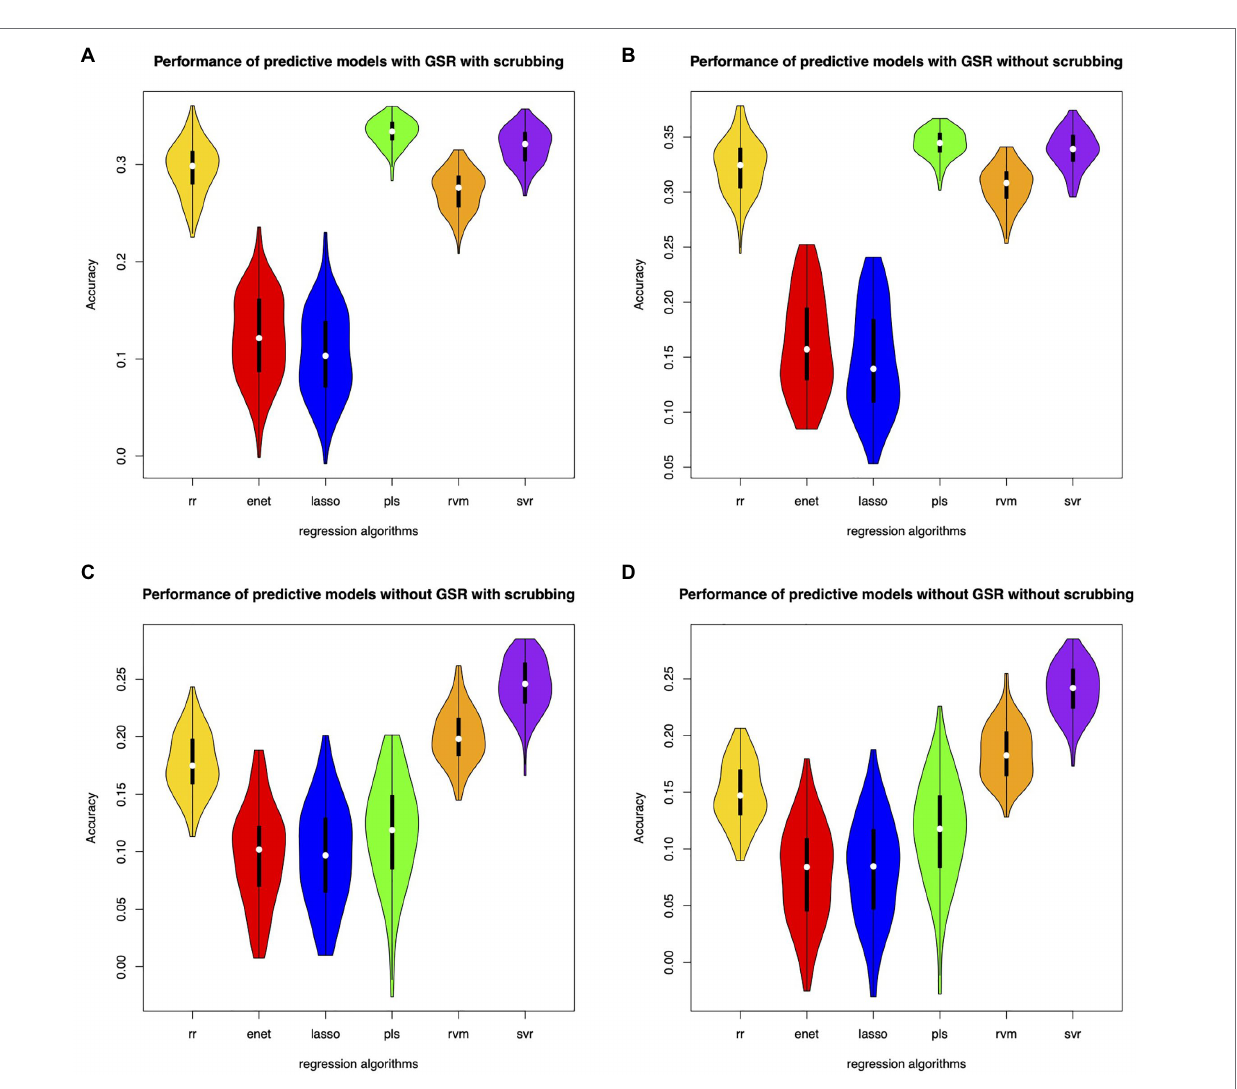
FIGURE 2 | Performance of the predictive models with classical feature selection ( p < 0.05). (A) denotes performance of the predictive models with GSR and scrubbing. (B) denotes performance of the predictive models with GSR and without scrubbing. (C) denotes performance of the predictive models without GSR and with scrubbing. (D) denotes performance of the predictive models without GSR and